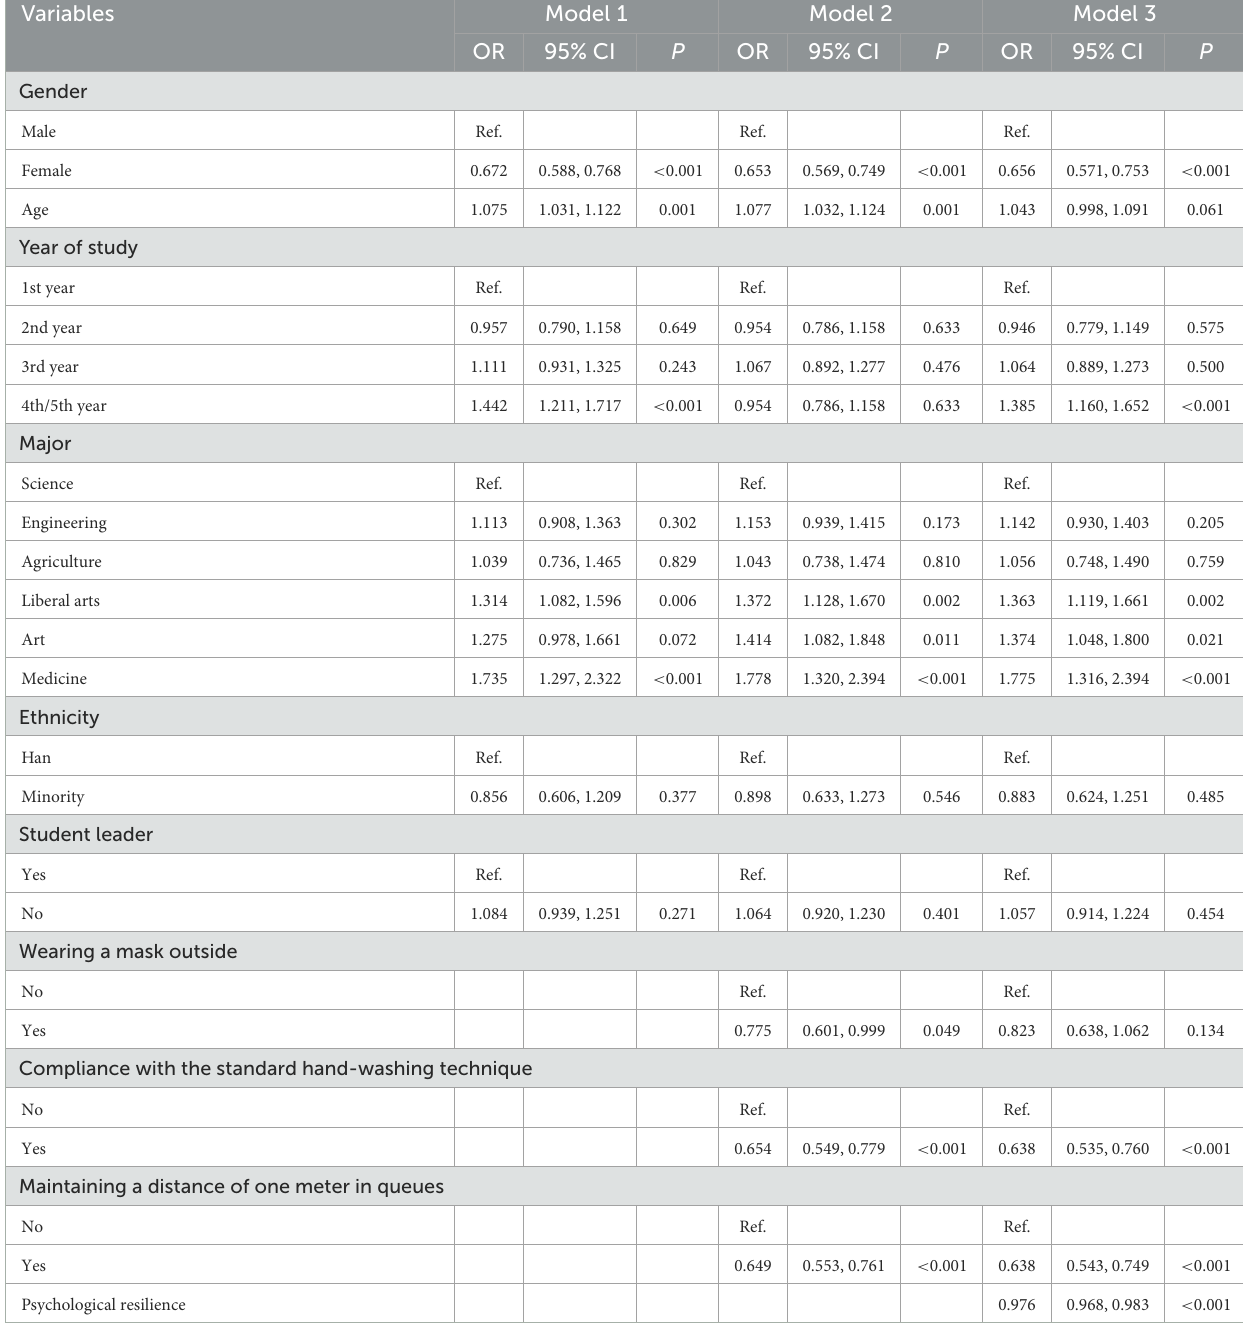
TABLE 5 Longitudinal associations of epidemic preventive behaviors and psychological resilience with stress based on